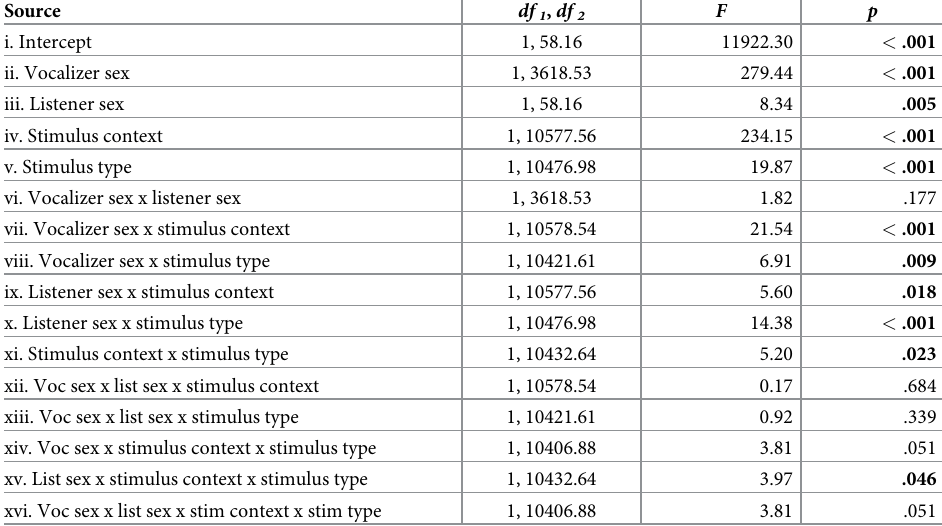
Table 4. Height attributions: Linear mixed model testing the effects of vocalizer sex, listener sex, stimulus context, and stimulus type on rated height. Source df